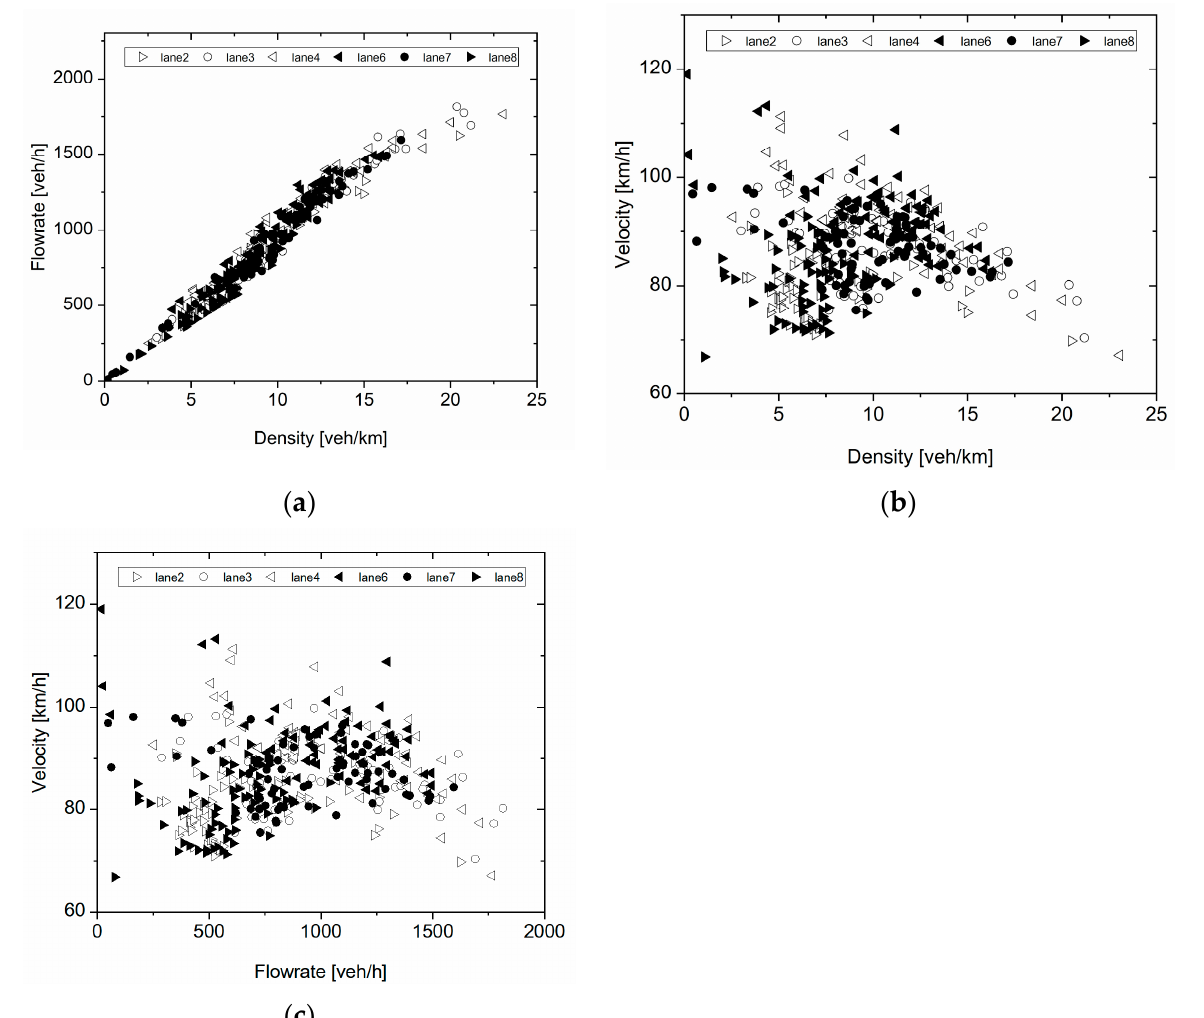
Figure 5. ( a ) Flow rate versus density; ( b ) Flow rate versus velocity; ( c ) Velocity versus density.